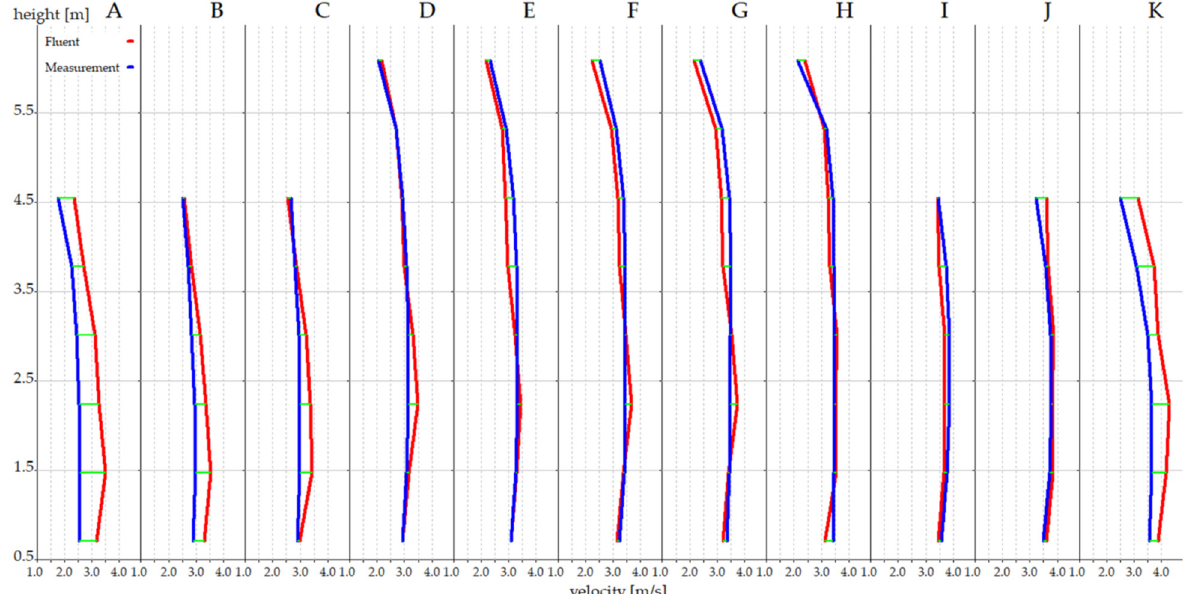
Figure 2. Comparison of measured and calculated velocity profiles for h r = 0.1 m. Stand-poles are marked by letters A–K. Thin green horizontal lines indicate differences.